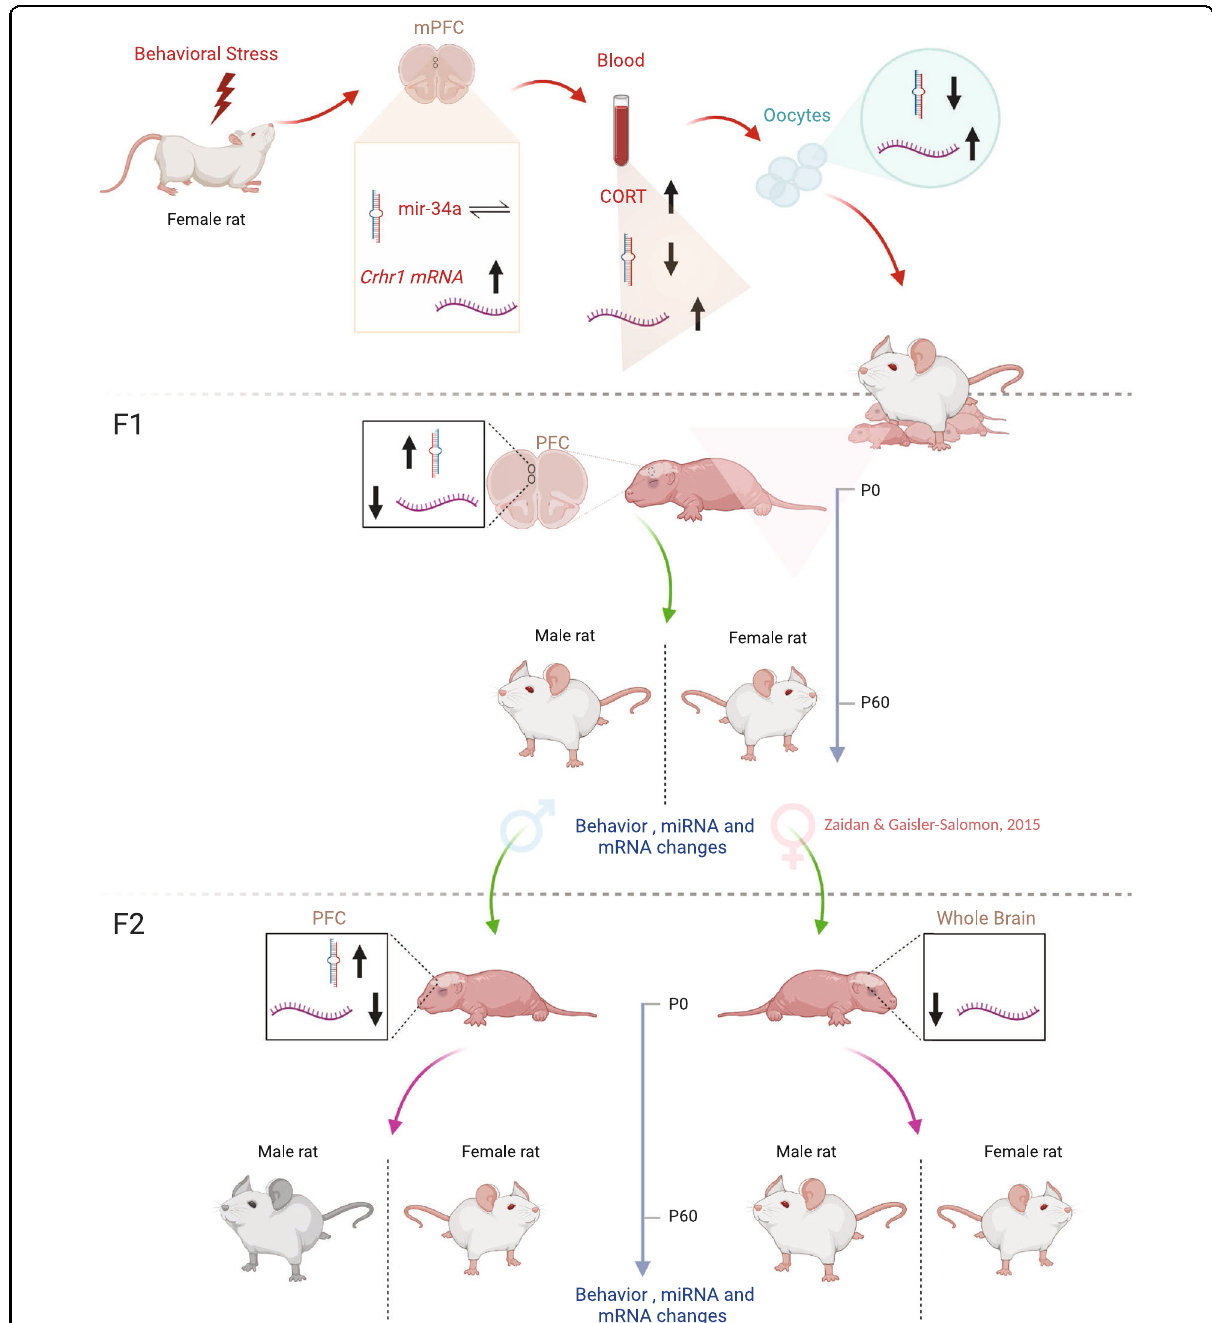
Fig. 7 Schematic summary of fi ndings in present study and previous investigations of stress transfer in this model. A potential mechanism for the inter- and trans-generational transfer of stress effects may involve stress-induced Crhr1 elevations in F0 brain, blood and oocytes; changes in mir-34 expression in blood and oocytes may be speci fi c markers for information transfer. Similar fl uctuations in Crhr1 and mir-34a are observed in PFC (and AMY, not shown) of neonate F1 and F2 progeny. Transfer via the maternal or paternal line affects male and female F2 progeny